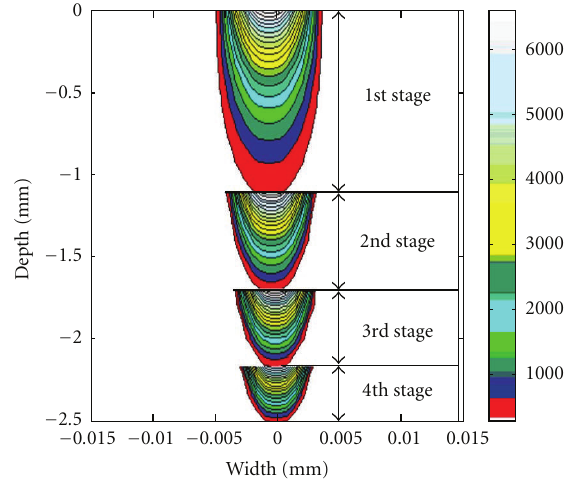
Figure 10: The first-stage temperature distribution; exposure time ( s ) = 2 . 25, total power ( W ) = 0 . 96, and surface temperature = 6 . 0201e + 003. The second-stage temperature distribution; expo- sure time ( s ) = 2 . 25, total power ( W ) = 0 . 1782, and surface temperature = 1 . 1175e + 003. The third-stage temperature distribution; exposure time ( s ) = 2 . 25, total power ( W ) = 0 . 19, and surface temperature = 1 . 2559e + 003. The forth-stage temperature distribution; exposure time ( s ) = 2 . 25, total power ( W ) = 0 . 0989, and surface temperature = 620 .